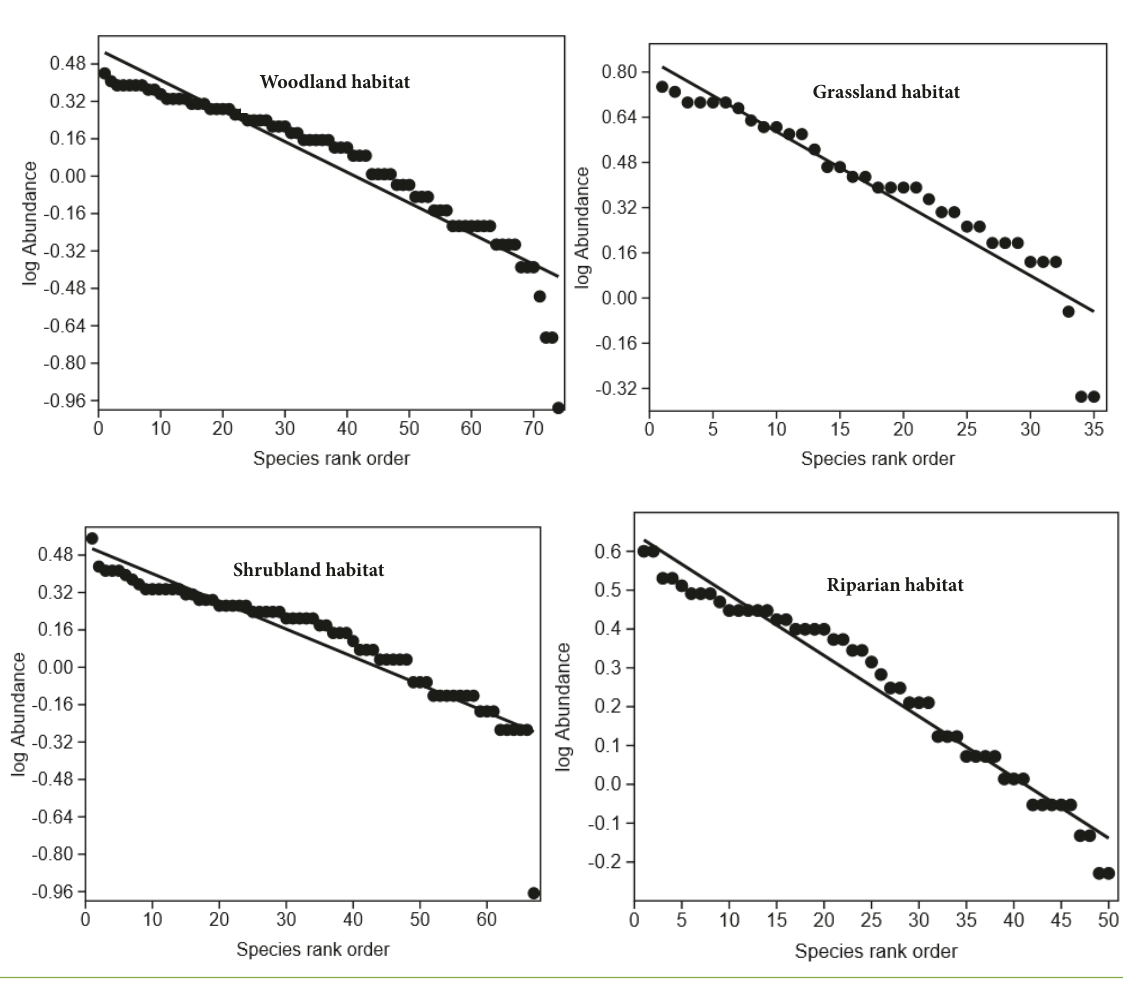
Figure3:GeometricmodelforbirdrankabundancedistributionacrossthefourhabitatsinMoleNationalPark,inthewetseason.Abundance is based on cumulative cover values per species per test site. Notice that SADs are ordered in a decreasing magnitude and plotted against the corresponding rank in this